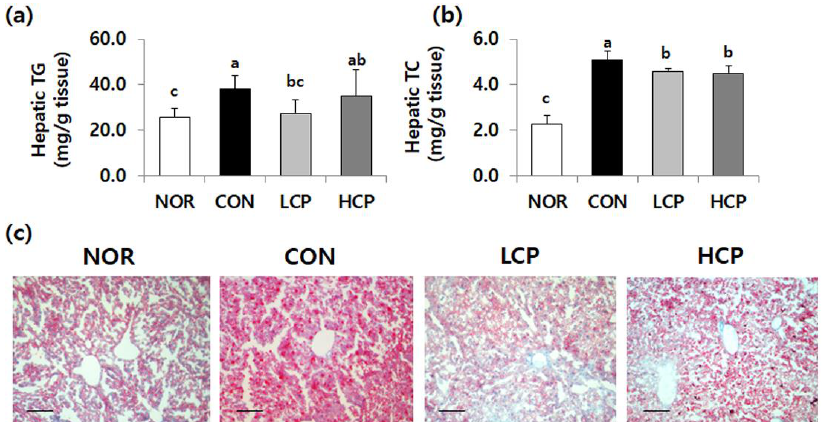
Figure 3. Effects of two skate skin-derived collagen peptides with different molecular weights on hepatic lipid levels ( a , b ) and lipid accumulation in the liver ( c ). Data are mean ± standard deviation (SD) ( n = 10 per group). Experimental groups were divided into four groups; m/m mice were orally administered water as a vehicle (NOR group) whereas db/db mice were orally administered water (control group, CON), LCP (LCP group), or HCP (HCP group) at a dose of 200 mg·kg bw -1 ·day -1 for 8 weeks. a–c Different letters mean significant differences to one-way analysis of variance (ANOVA), followed by Duncan’s multiple-range test at p < 0.05. Histological analysis of liver tissue was performed using oil red O staining, magnification: 100×, bar: 100 μm.